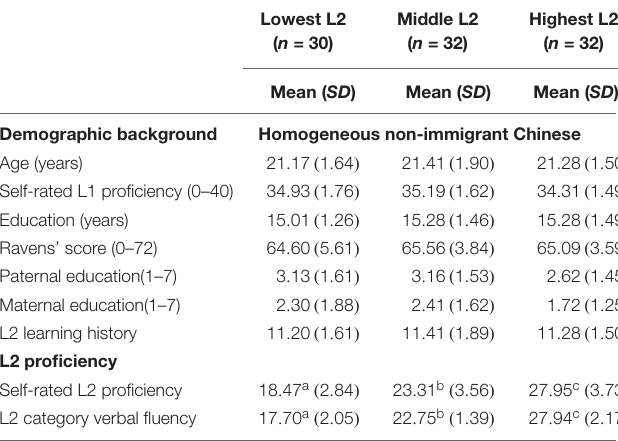
TABLE 1 | Characteristics of participant